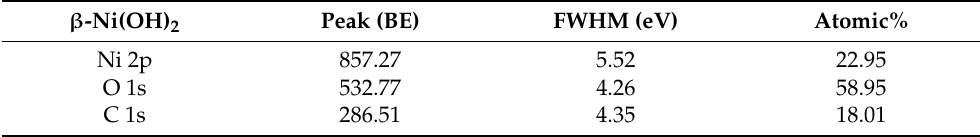
Table 1. Binding energy (eV), FWHM, and atomic percentage for the synthesized β -Ni(OH) 2 . β -Ni(OH)